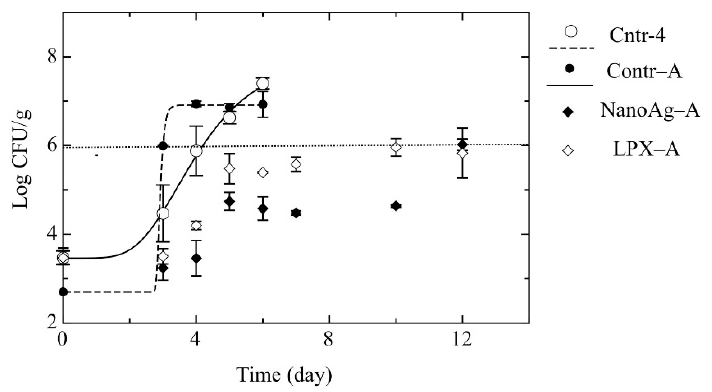
Figure 4. Evolution of Pseudomonas spp. for burrata samples of Step 4 ( ○ Cntr ‐ 4: Burrata packaged in